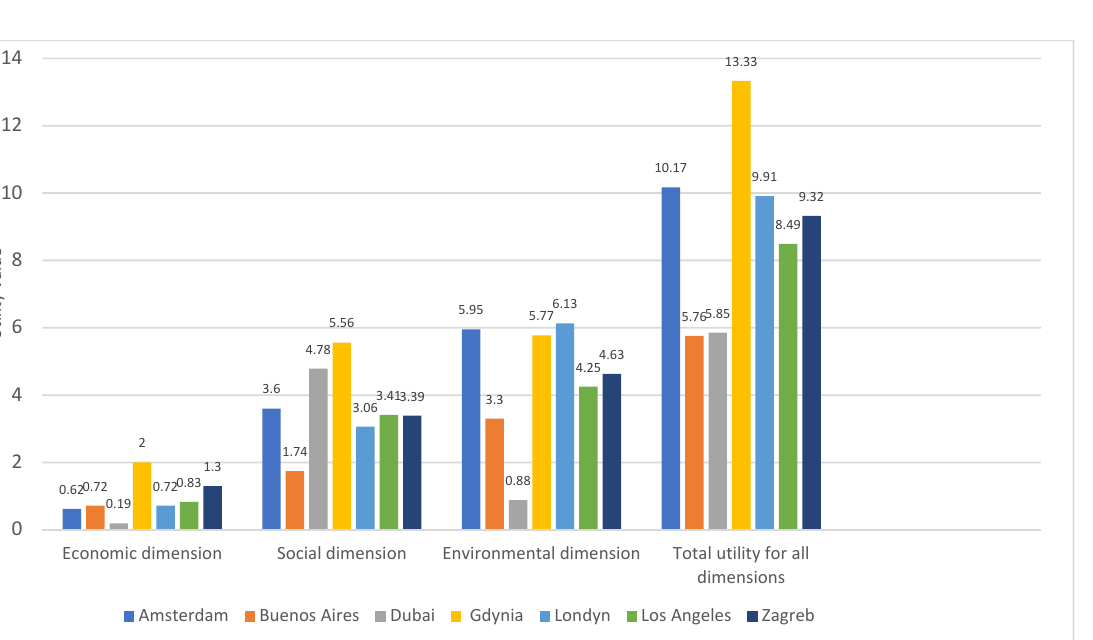
Figure 4. Comparison of total utility by dimensions for the analysed cities.